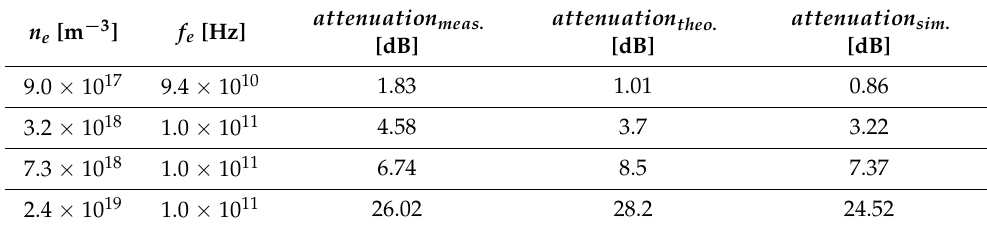
Table 5. The comparison of the transmission function at 220 GHz.